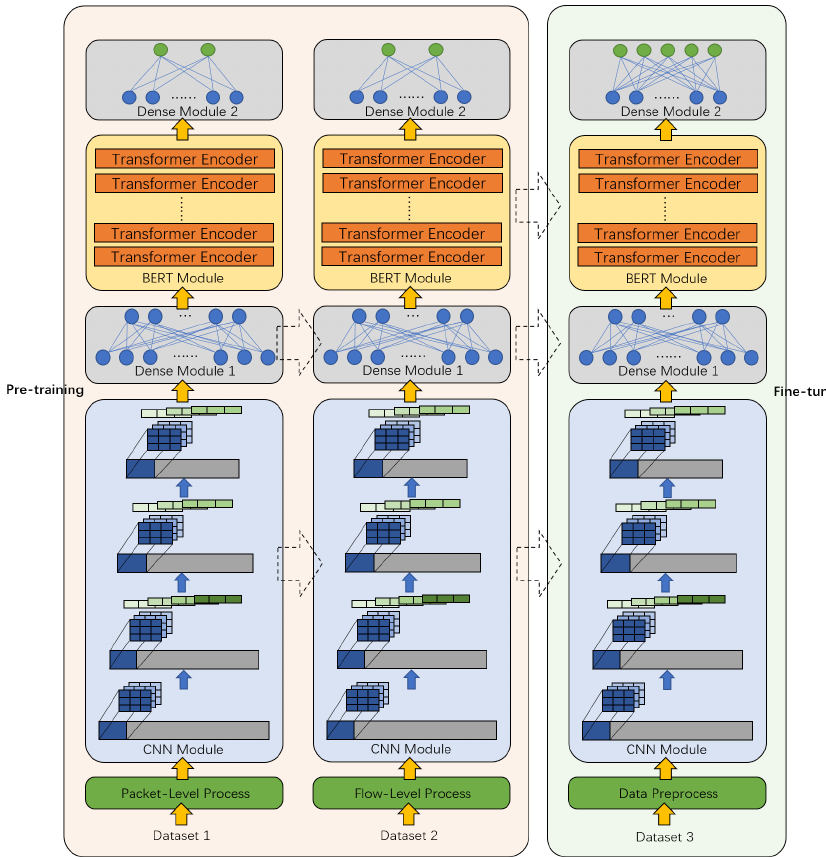
Figure 1. The overall framework of the CBD